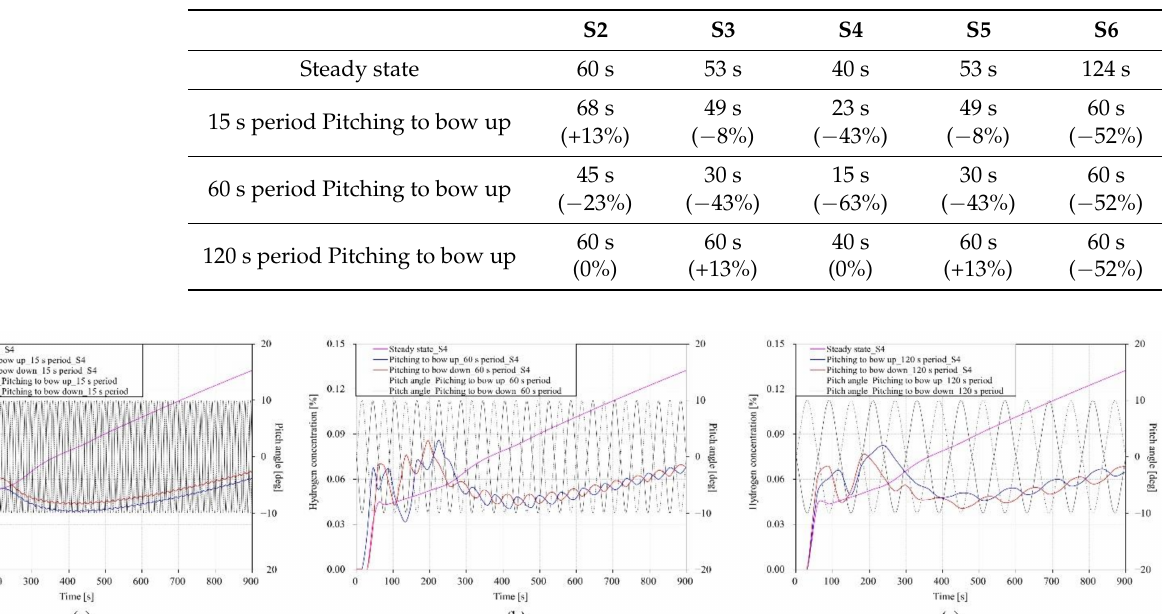
Table 6. Time for hydrogen to reach each sensor according to ship motion periods.